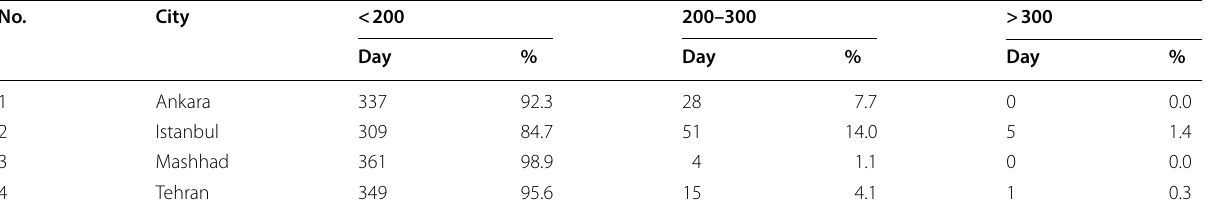
Table 2 Classification of SWEAT daily data for the study areas based on the weather severity in 2018 No.